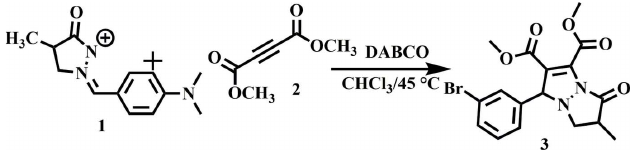
Figure 6 Scheme showing the synthesis of the title compound.